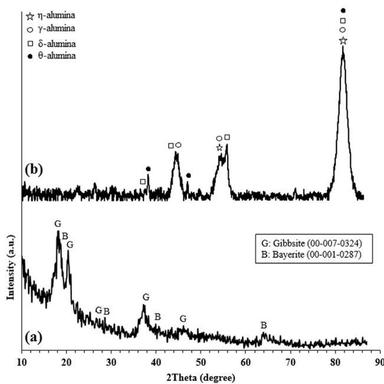
XRD pattern of the as-fabricated (a) 1-h aged Al(OH)3 and (b) the assynthesized mesoporous alumina. Fig. 5. Williamson-Hall plot for the as-synthesized MA.